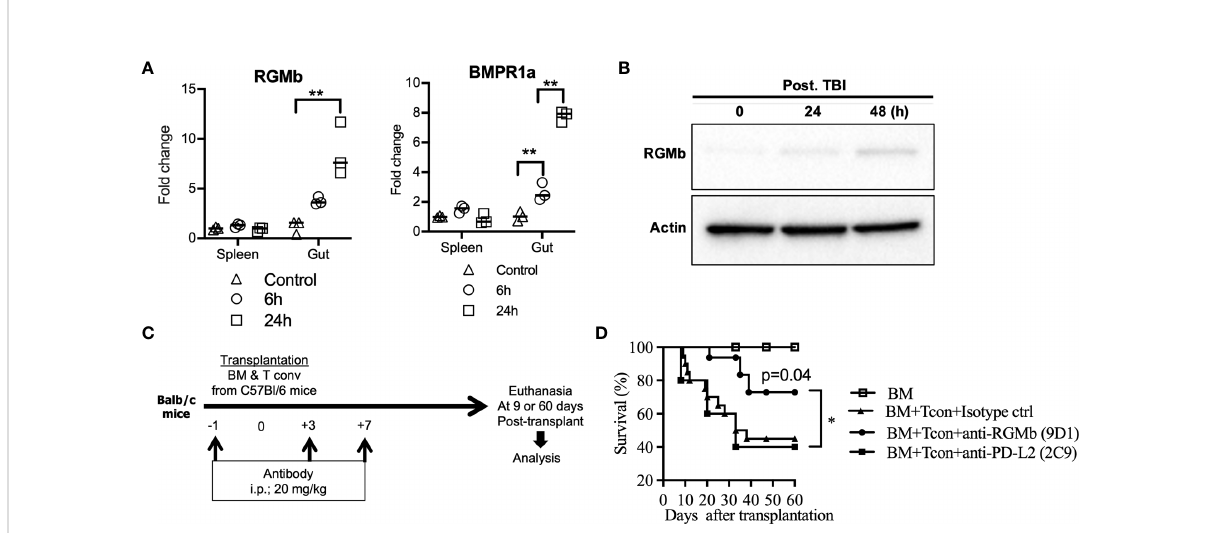
FIGURE 1 Treatment with anti-RGMb antibody 9D1 reduces GvHD. (A) To analyze the effect of TBI on RGMb expression in spleen and gut, RGMb and BMPR1a mRNA expression were quanti fi ed by qPCR at 6 and 24h after TBI and (B) RGMb protein expression in the gut was examined by western blotting at 24 and 48h after TBI. One-way ANOVA comparisons (C) To assess the capacity of anti-RGMb-(BMP2,4, NEO1 & PD-L2 blocking) or anti-PD-L2 (RGMb but not PD-1 blocking) antibody treatment to prevent GvHD, mice were injected with 9D1 or 2C9 antibody (20 mg/Kg; i.p.) at the indicated times. (D) Survival was monitored for 60 days after BM transplantation. Results are expressed as mean ± SEM (n ≥ 5/ group). * p ≤ 0.05, ** p ≤